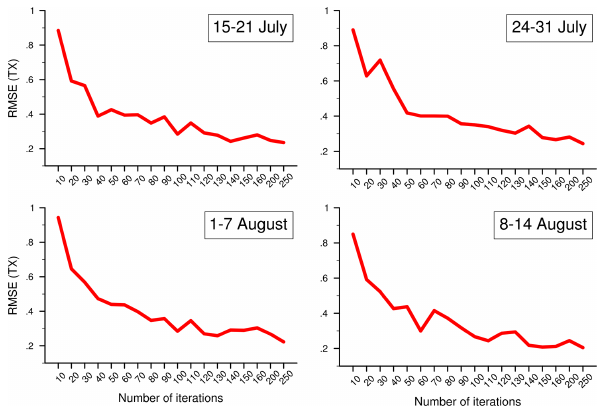
Figure A2. Convergence (assessed by the RMSE, unit: ◦ C) of the TX reconstruction as a function of the number of iterations used in the dynamical adjustment algorithm. Convergence is assessed against a reference dynamical adjustment run performed with 300 iterations. Four multi-day periods (dates in upper right corner) within the 2010 Russian summer heat wave are considered to per- form the sensitivity test. The RMSE is first estimated at each grid point and then averaged over the 35–65 ◦ N, 25–50 ◦ E geographical box with latitudinal